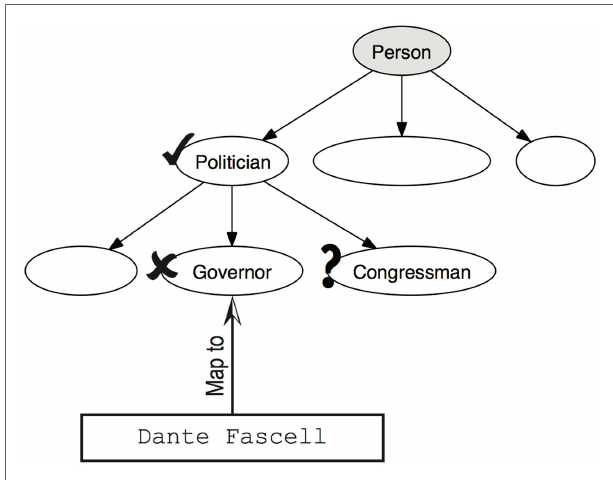
FigUre 3 | Description of the